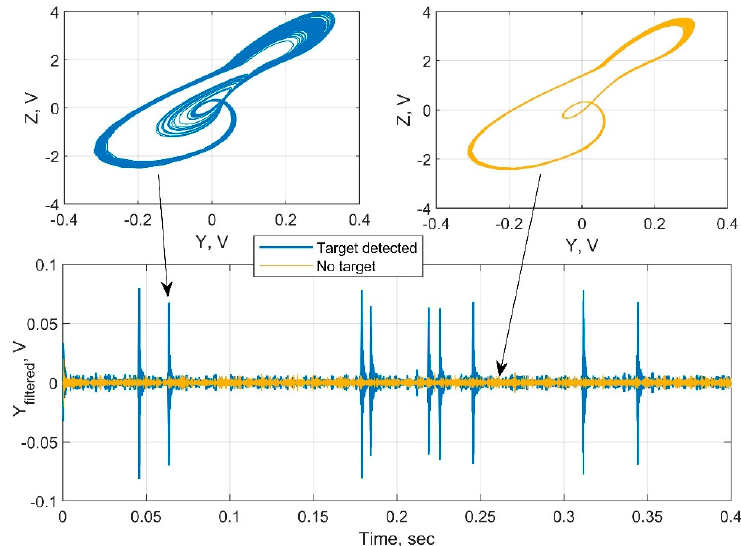
Figure 21. Attractors and filtered output of the oscillations in the idle state and when the target appears.